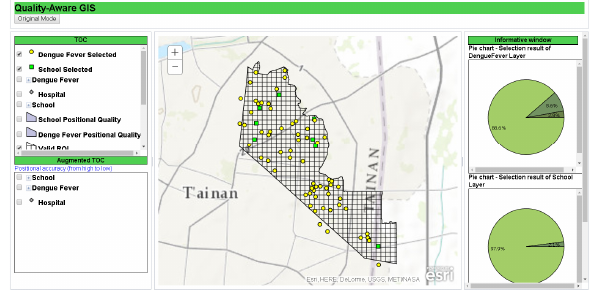
Figure 16. Output of selected